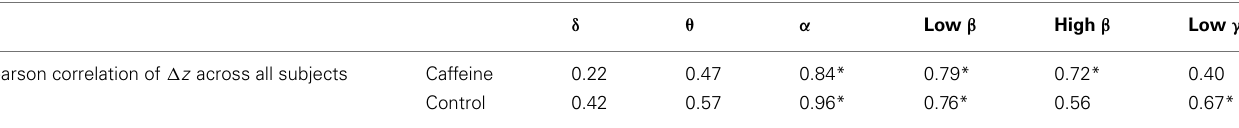
Table 3 | Correlation (Pearson) of the connectivity changes in the wide-band MEG to the connectivity changes in each of the six MEG frequency bands of interest (eyes closed condition).